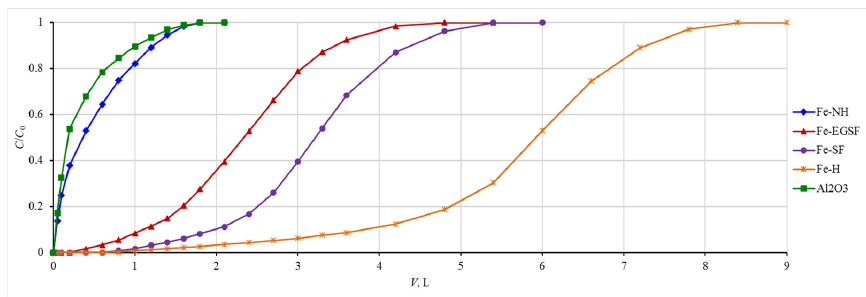
Figure 11. Dynamic curves of sorption of stable beryllium as a tracer of sorption efficiency. The DEC and TDEC determined for the studied sorbents are shown in Table 4. Table 4. Values of DEC and TDEC of various sorbents for phosphorus or